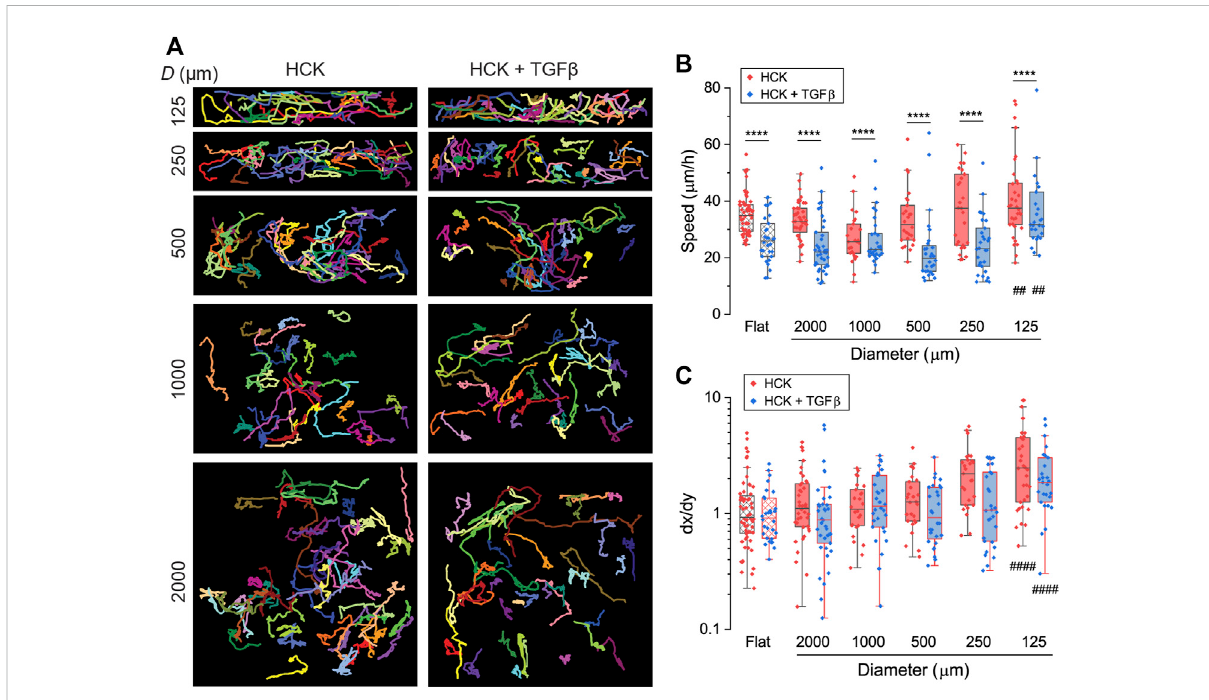
FIGURE 5 MigrationofHCKandHCK+TGF β cellsonconcavecylinders. (A) Migrationtracksofcellsonconcavecylinderswithdiametersbetween125and 2000 µm. Every colored track represents an individual cell, with at least 26 cells per condition. (B) Migration speed of individual cells (dots) on concave cylinders. (C) Directionality index dx/dy of individual cells (dots) on concave cylinders. ****: p < 0.0001 for comparisons between HCK and HCK + TGF β cells for the same curvature; #### : p < 0.0001 for comparisons against fl at control for either HCK or HCK + TGF β cells; all other comparisons are not statistically signi fi